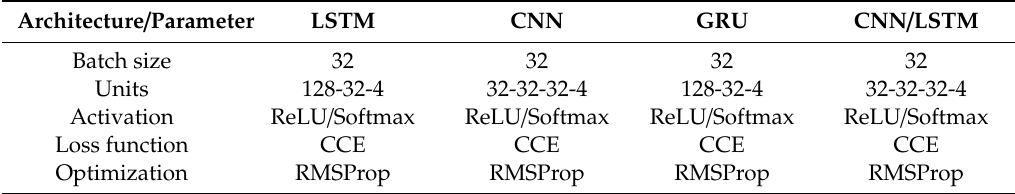
Table 1. Main network parameters.